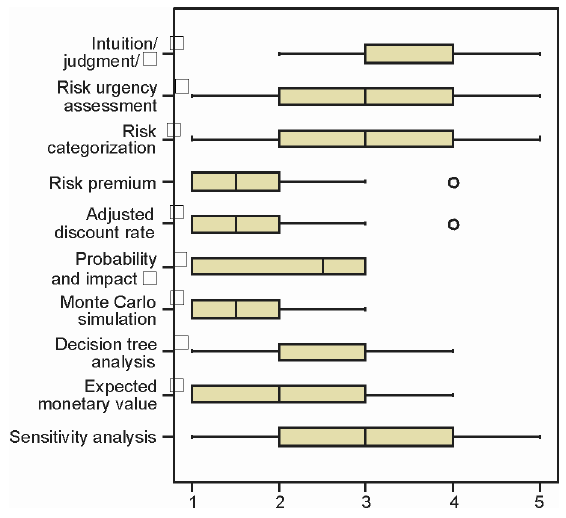
Fig. 8. Risk analysis technique usage in PPP projects